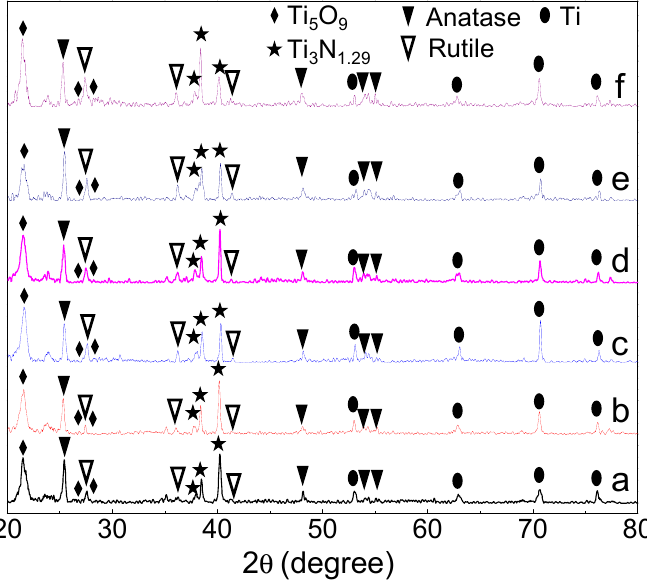
Figure 1. ( a – f ) X-ray diffraction (XRD) patterns of the micro-arc oxidation (MAO) specimens with different N implantation doses: Ti-MAO-N0.1, Ti-MAO-N0.5, Ti-MAO-N1.0, Ti-MAO-N5.0, Ti-MAO-N10, and Ti-MAO-N20.